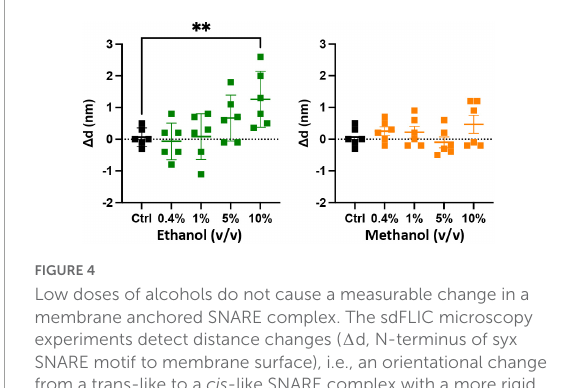
FIGURE4 Low doses of alcohols do not cause a measurable change in a membrane anchored SNARE complex. The sdFLIC microscopy experiments detect distance changes ( (cid:49) d, N-terminus of syx SNARE motif to membrane surface), i.e., an orientational change from a trans-like to a cis -like SNARE complex with a more rigid linker between syntaxin’s SNARE motif and trans-membrane domain. When caused by changes in membrane order, this change correlates with enhanced fusion probability (Kiessling et al., 2018). However, no significant changes in SNARE orientation were detected following addition of up to 5% ethanol and up to 10% methanol. Shown are the changes in the distance of syx*192-Alexa546 to the membrane surface compared to control (see Supplementary Figure 4 for example images, data fit, and histograms) [ ∗∗ p < 0.01 (one-way ANOVA), n = 6].